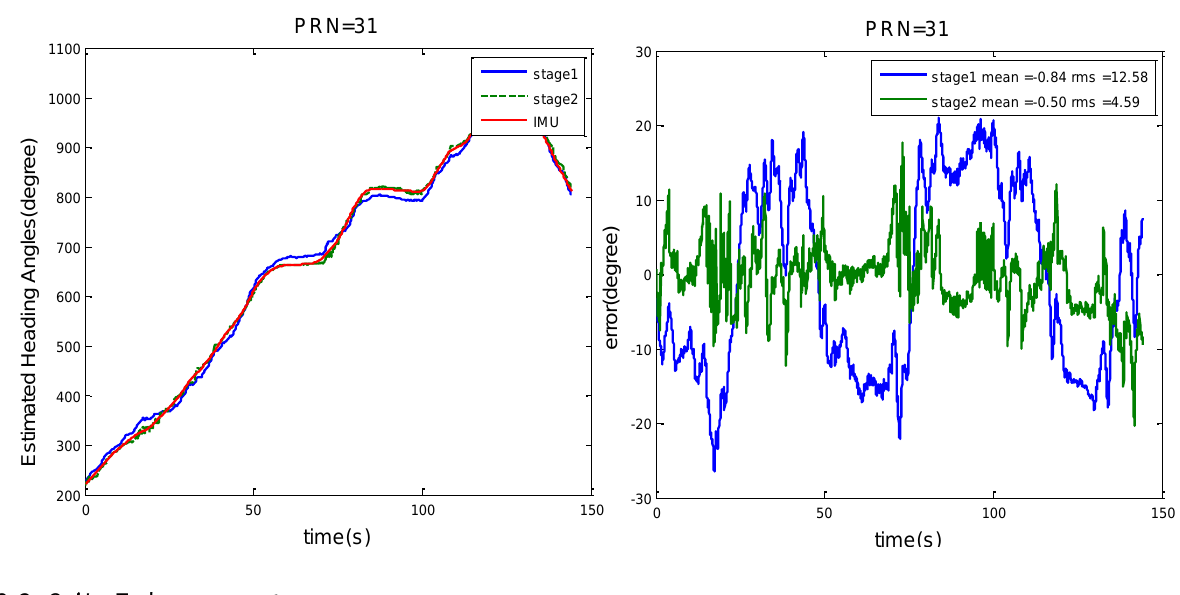
Figure 13. Heading angle determination results for PRN 31 when this PRN is not used in the calibration